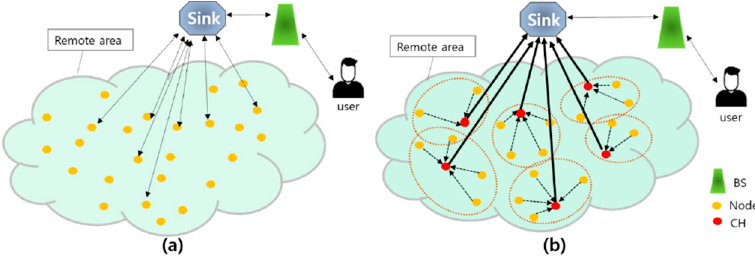
Figure 3. Diagram of WSN. ( a ) Flat networks routing protocols. ( b ) Hierarchical routing protocols (Low-Energy Adaptive Clustering Hierarchy (LEACH)).